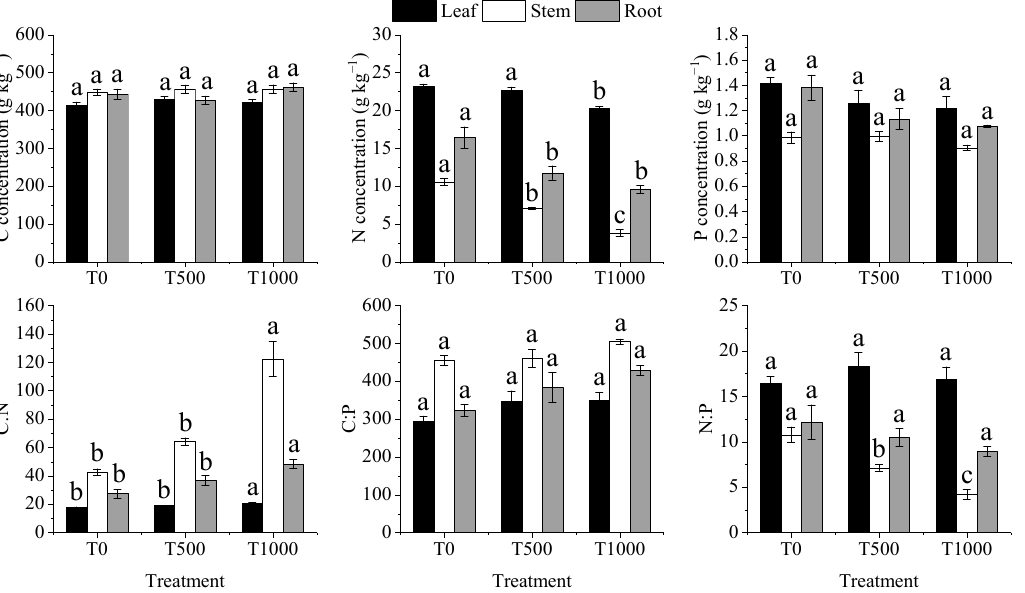
Figure 1. The N, P, and K concentration and their stoichiometric pattern in R. chinensis under different treatments. Each value represents the mean of three replicates ± SE. Different letters indicate significant difference between the treatments derived from the same organ ( p < 0.05).